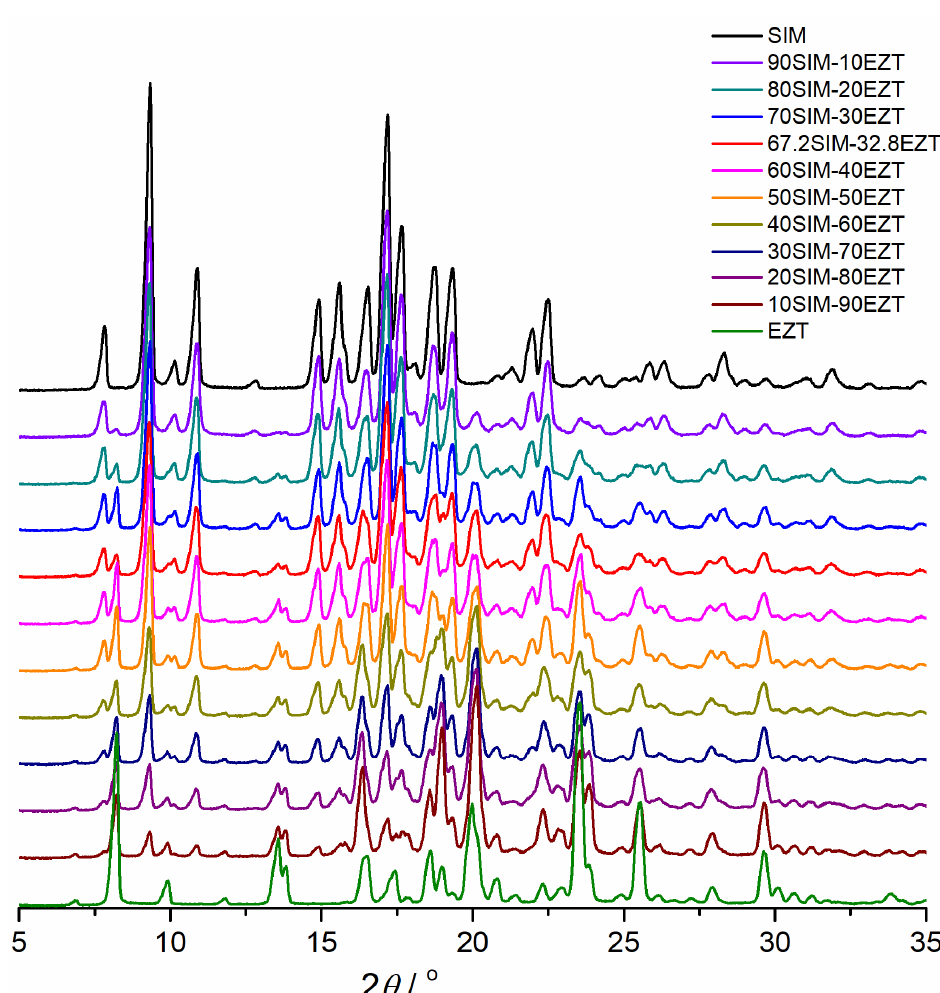
Figure 5. X-ray diffraction patterns of SIM, EZT, and obtained SIM-EZT SDs.